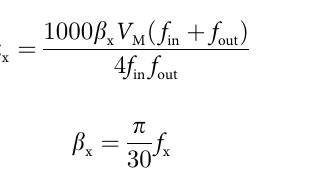
Table 1. Parameters and expressions used to calculate α